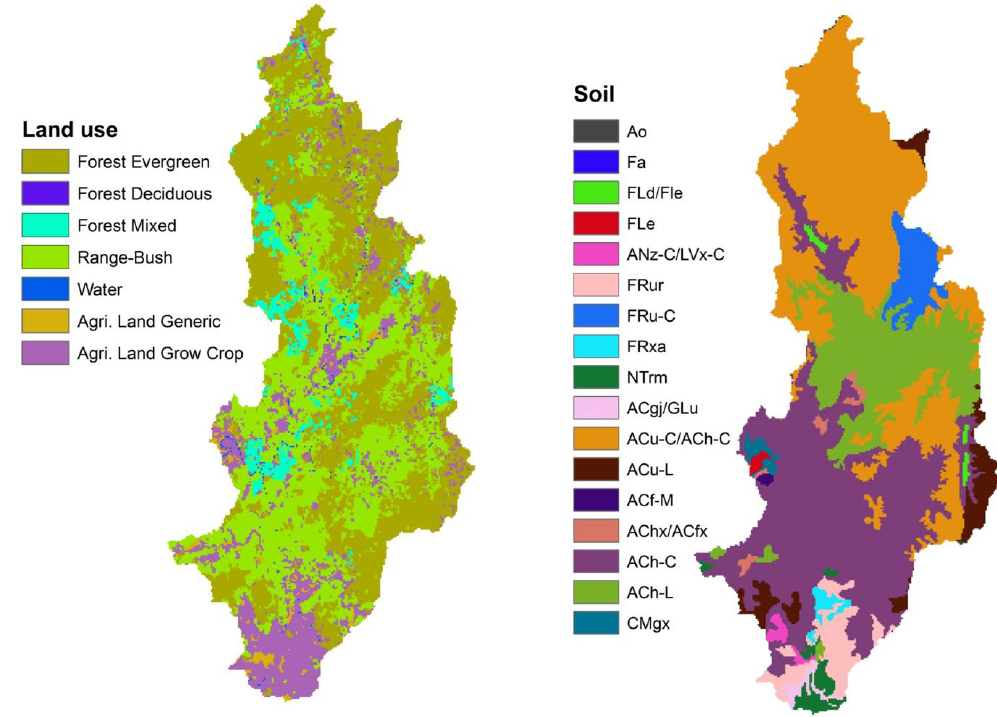
Figure 2. Land use and soil map of Dak Bla river basin 2 Fig. 2. Land use and soil map of Dak Bla river